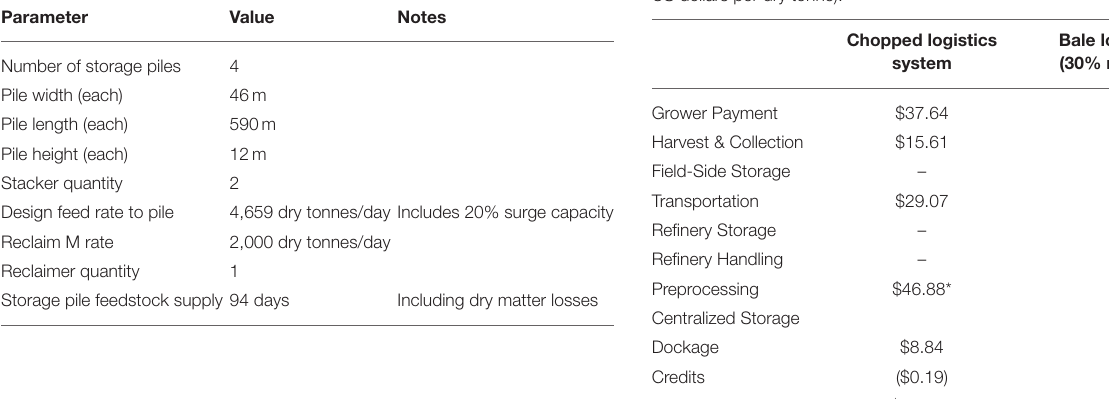
TABLE 6 | Storage pile design summary for the chopped logistics system. TABLE 7 | Comparison of costs in chopped and baled logistics systems (2015 US dollars per dry